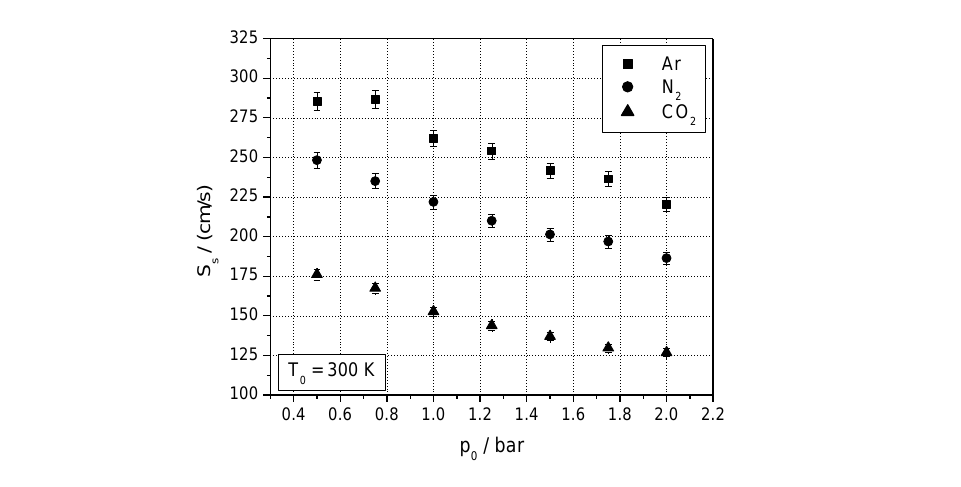
Figure 4. PVs of propane-air–10% diluent mixtures (Ar, N 2 or CO 2 ) at initial ambient temperature and various initial pressures.